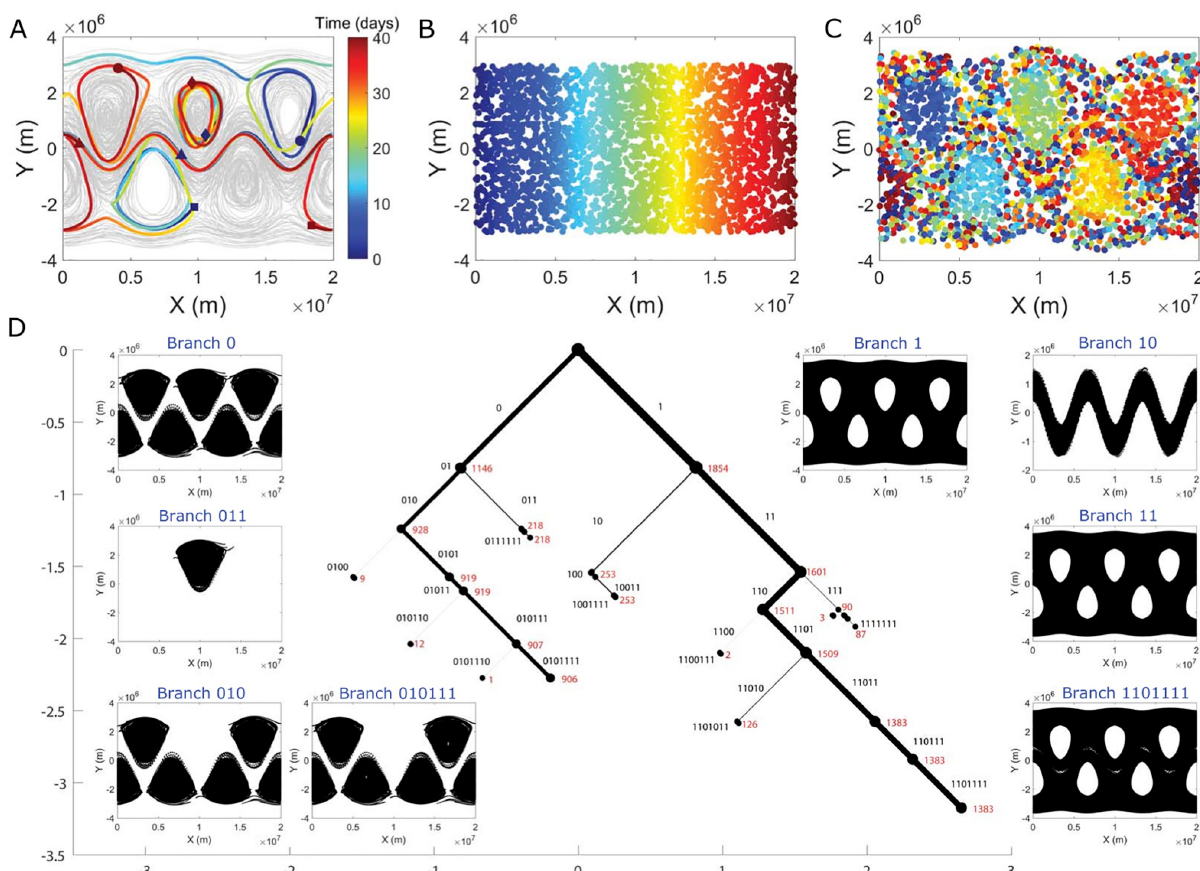
Fig 4. Bickley jet atmospheric flow model. (A) Trajectories of 75 selected Lagrangian particles randomly initialized in the flow (gray). The trajectories of 4 particles are highlighted for a 40-day integration period, from their initial positions (blue) to their final positions (red). These particles illustrate qualitatively different trajectories in the flow, including those the remain in a single flanking eddy (diamonds), those that pass between multiple eddies (dots and squares), and those in the meandering jet (triangles). In panel (B), the initial positions of 3000 particles are colored according to their position along the east-west axis of the flow. The particles maintain their color assignment in panel (C), showing how the unsteady jet and eddy motions lead to mixing of the particles after 40 days. A periodic boundary condition is applied in the east-west direction. The resulting sCSC dendrogram is shown in panel (D), with every position occupied by all 3000 particles plotted in black dots in the corresponding inset branch plot (note that particle positions often appear as continuous black patches due to the high density of overlapping positions occupied by the particles). The width of each branch is proportional to the fraction of the states that it contains. The corresponding binary code of each branch is labeled in black text, and the number of trajectories associated with each node is labeled in red text. The dendrogram is plotted to the seventh eigenvector, although many of the labels are omitted for clarity. The horizontal and vertical axes are measured in units of the parameter z , and the branches are plotted at 45-degree angles. We have visualized the first 7 eigenvectors for brevity of presentation.